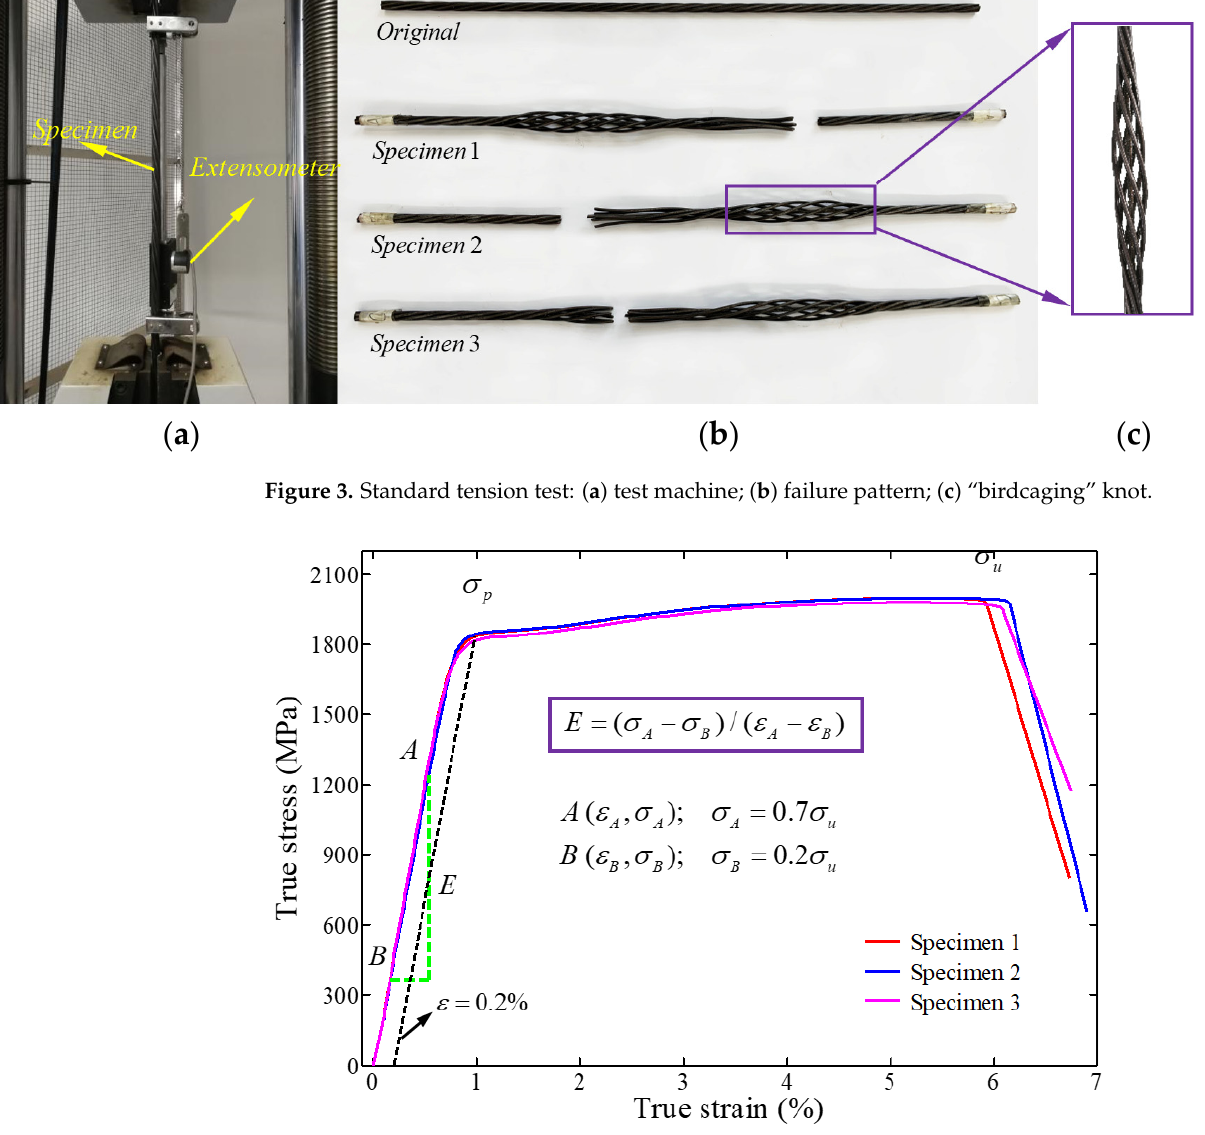
Figure 3. Standard tension test: ( a ) test machine; ( b ) failure pattern; ( c ) “birdcaging” knot.